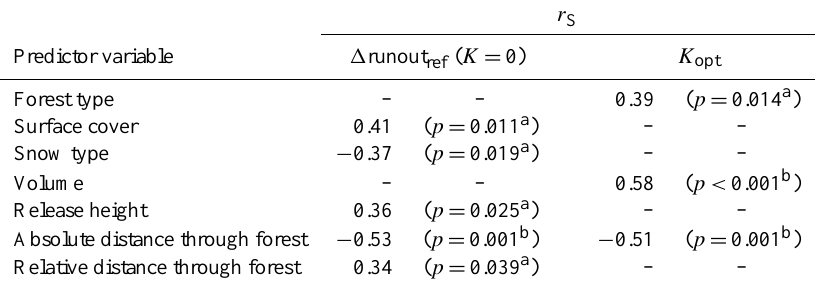
Table 2. Significant a (0.01 <p ≤ 0.05) and highly significant b ( p ≤ 0.01) Spearman rank correlation coefficients ( r S ) between predictor variables and 1 runout ref calculated for the reference simulation runs with K = 0, and between predictor variables and the assigned optimal value for K ( K opt